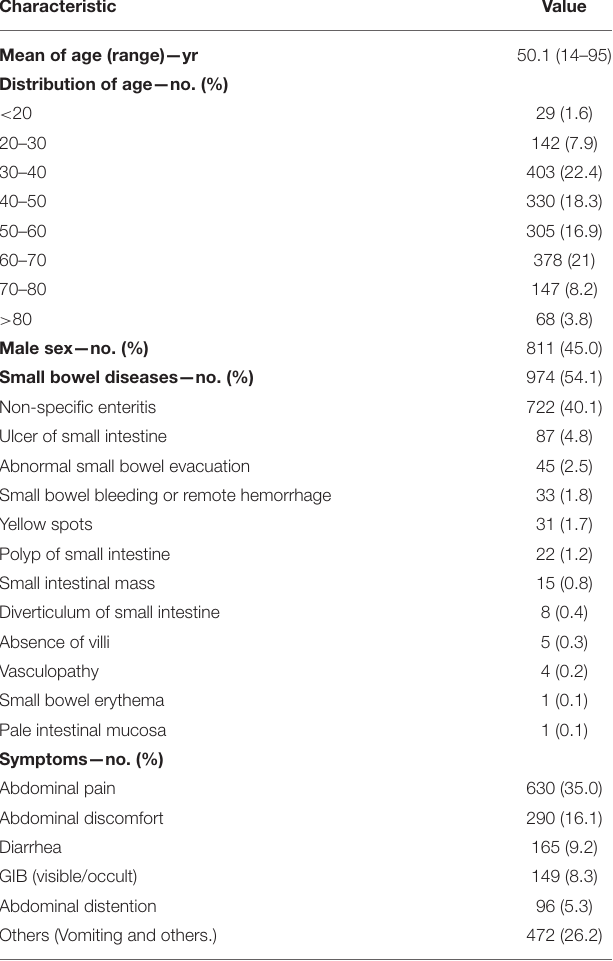
TABLE 1 | Patient demographics and clinical